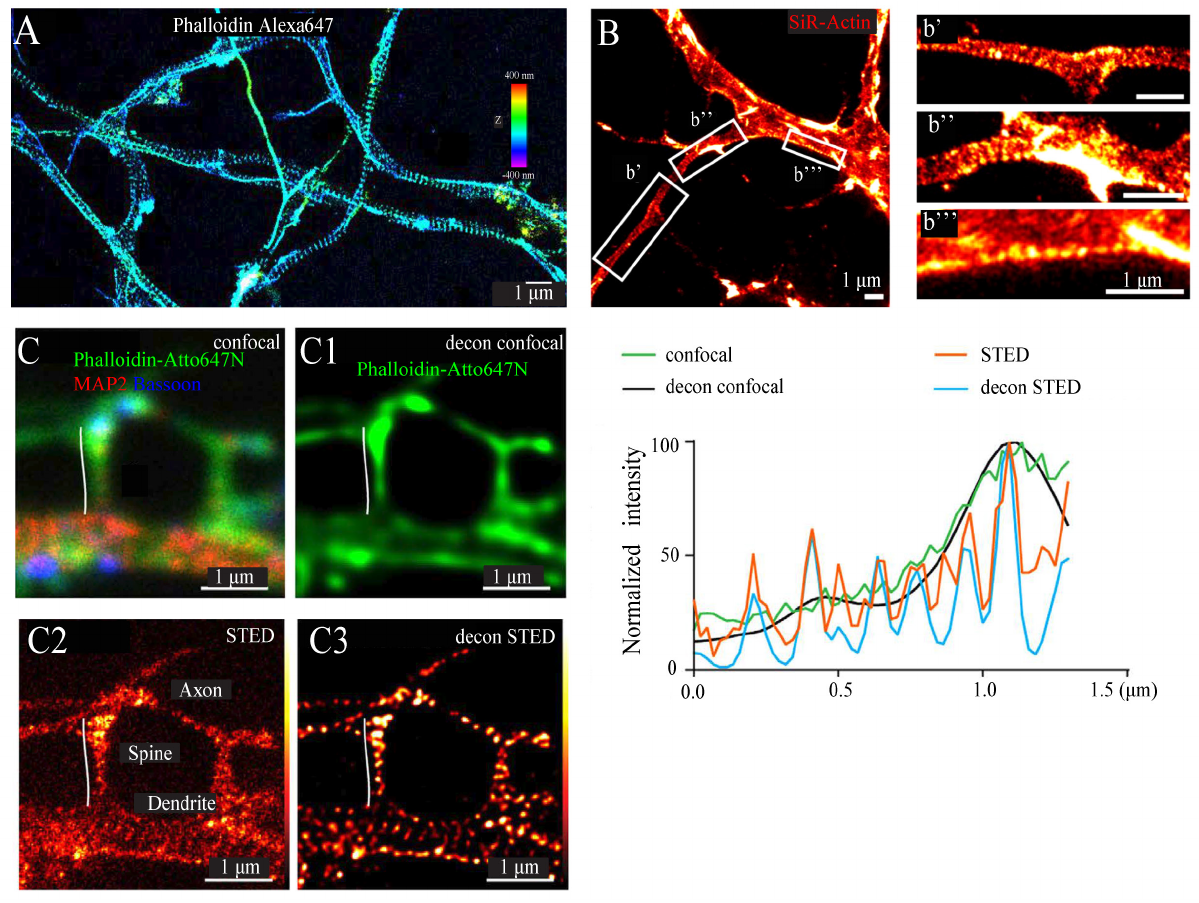
Figure 1. Cytoskeleton structures in the nervous system. (A) 3D STORM image showing periodic organization of actin filaments stained with Phalloidin-Alexa 647 in neurons. A is adapted from Zhong et al., 2014 (2). (B) STED image shows actin pattern in a living oligodendrocyte stained with SiR-Actin. c’, c’’and c’’’ are the enlarged figures indicated in C showing the periodic actin structures in dendritic-like processes. B is adapted from D’Este et al., 2016 (6). (C and C1) Conventional images show a dendrite with spines, stained with Phalloidin-Atto647N (green), dendritic marker MAP2 (red), and pre-synaptic marker Bassoon (blue). (C2) STED and (C3) deconvolution STED image shows periodic distribution of actin filaments in dendrite shafts as well as in dendrite spines. C is adapted from Bär et al., 2016 (56). In right panel, normalized line profiles of phalloidin-Atto647N intensity along the spine necks indicated in (C-C3) for raw and deconvolved confocal and STED